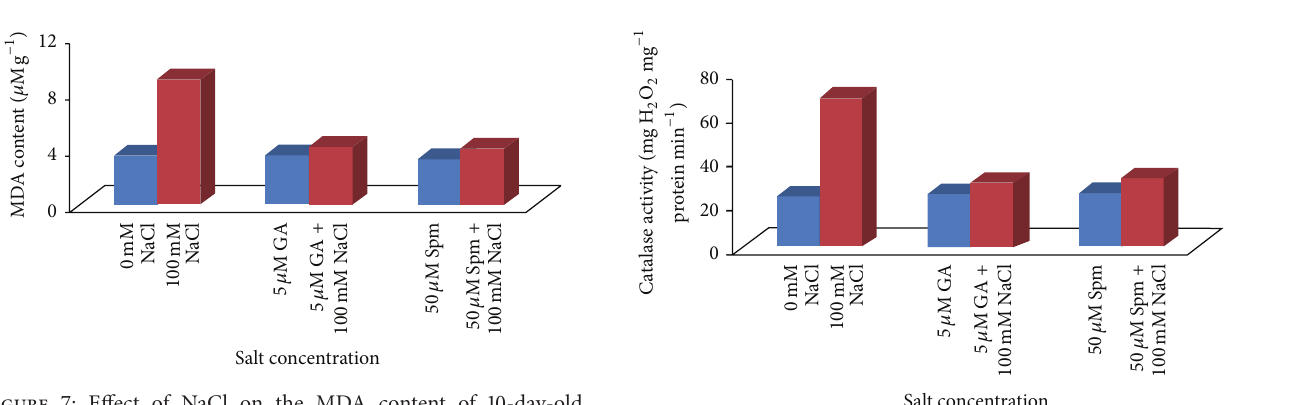
Figure 7: Effect of NaCl on the MDA content of 10-day-old mungbean seedling and its possible amelioration with 5 𝜇 M GA 3 and 50 𝜇 M Spm.